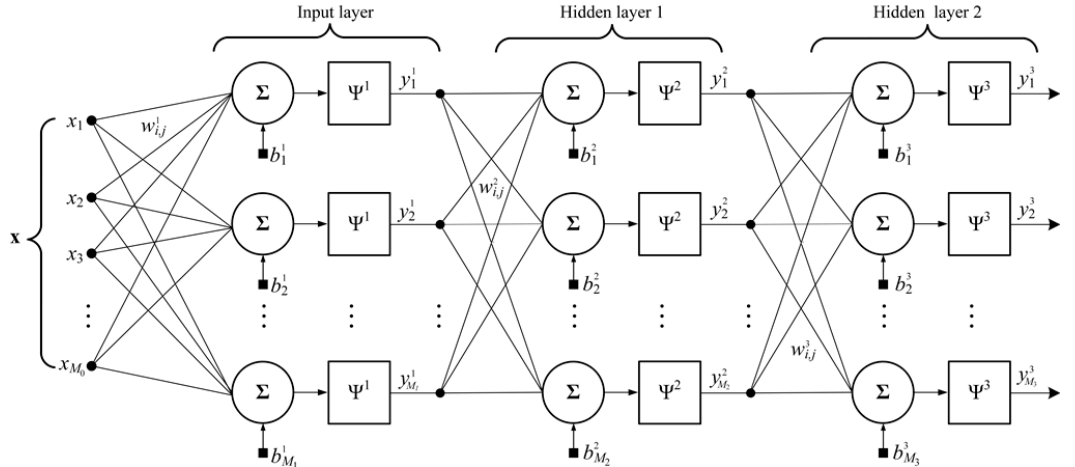
Figure 1. Typical architecture of a one input, two hidden, and one output layered feed-forward MLP ANN.